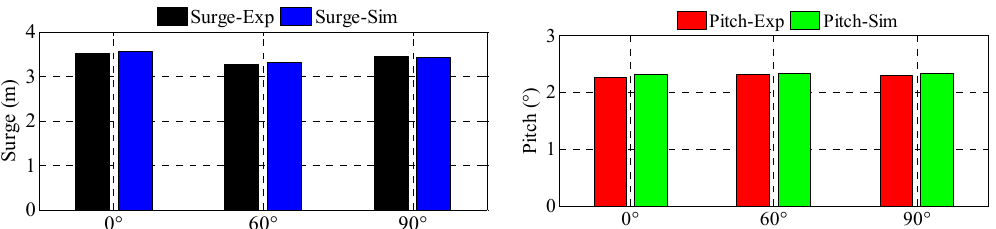
Figure 15. Comparisons of average surge and pitch motion in three wind headings.